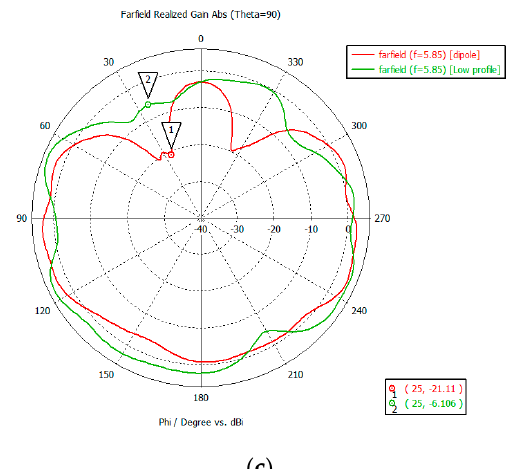
Figure 7. Two-dimensional null value comparison of monopole-only (red color) and monopole with quadruple closed-loop devices (green color) at the angles of ( a ) 80°; ( b ) 85°; and ( c ) 90°.